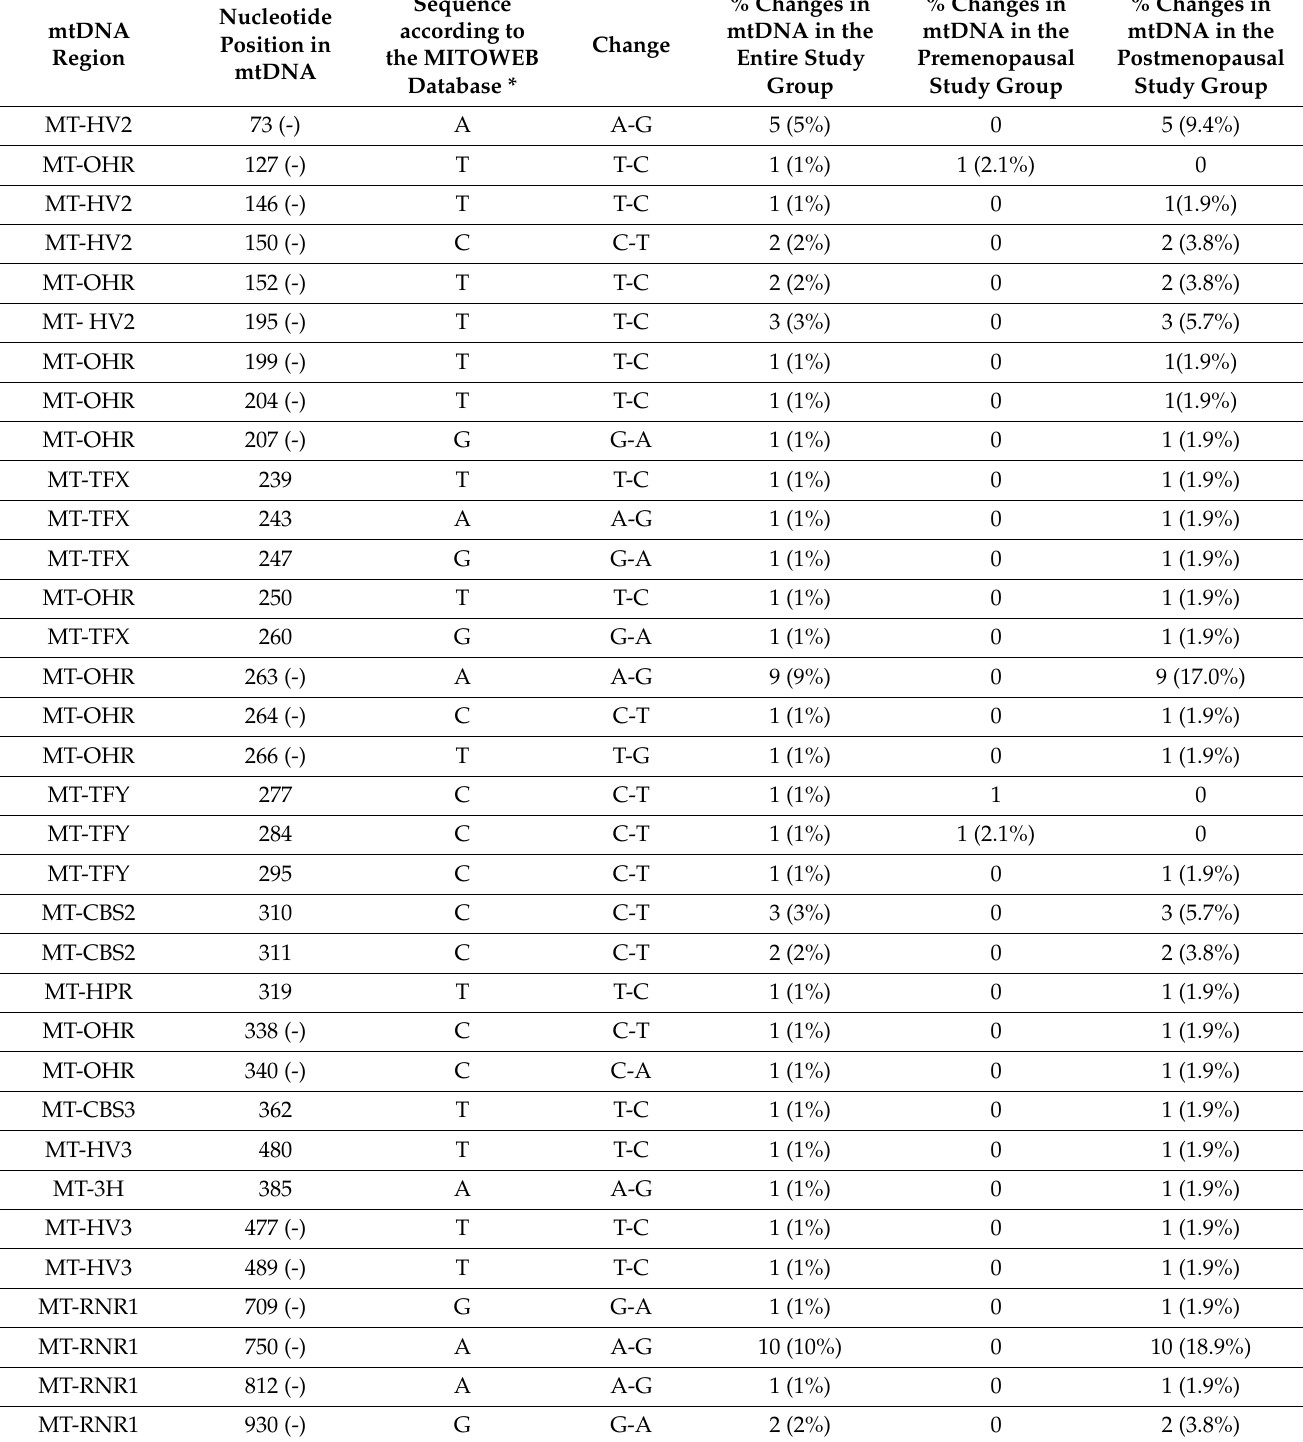
Table 1. List of changes in mtDNA in the HV1, HV2, and 12S RNA regions in the entire study group of women and in the group of pre- and postmenopausal